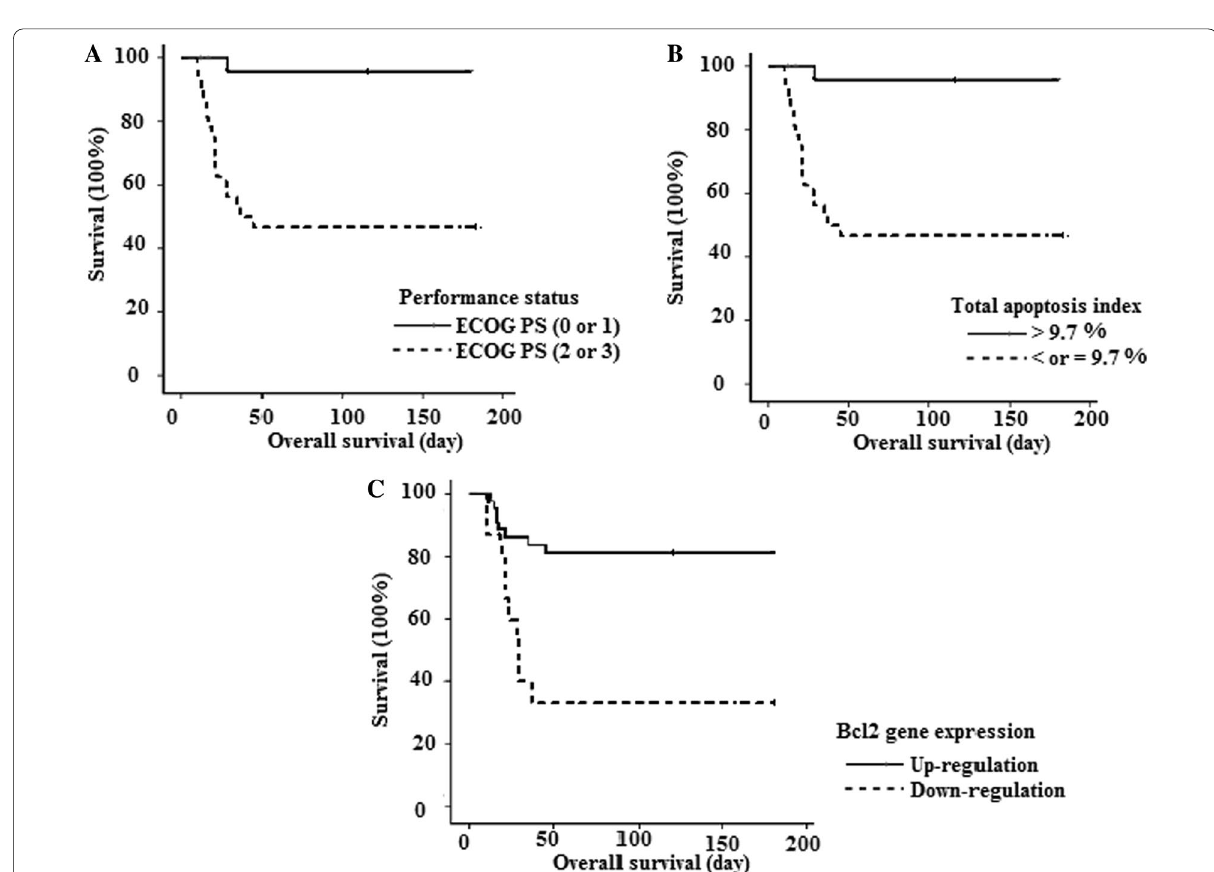
Fig. 2 Kaplan–Meier survival curves and log‑rank test. A Performance status. B Total apoptosis. C BCL2 gene expression, in non‑acute promyelocytic leukemia—AML patients. Eastern Cooperative Oncology Performance Status